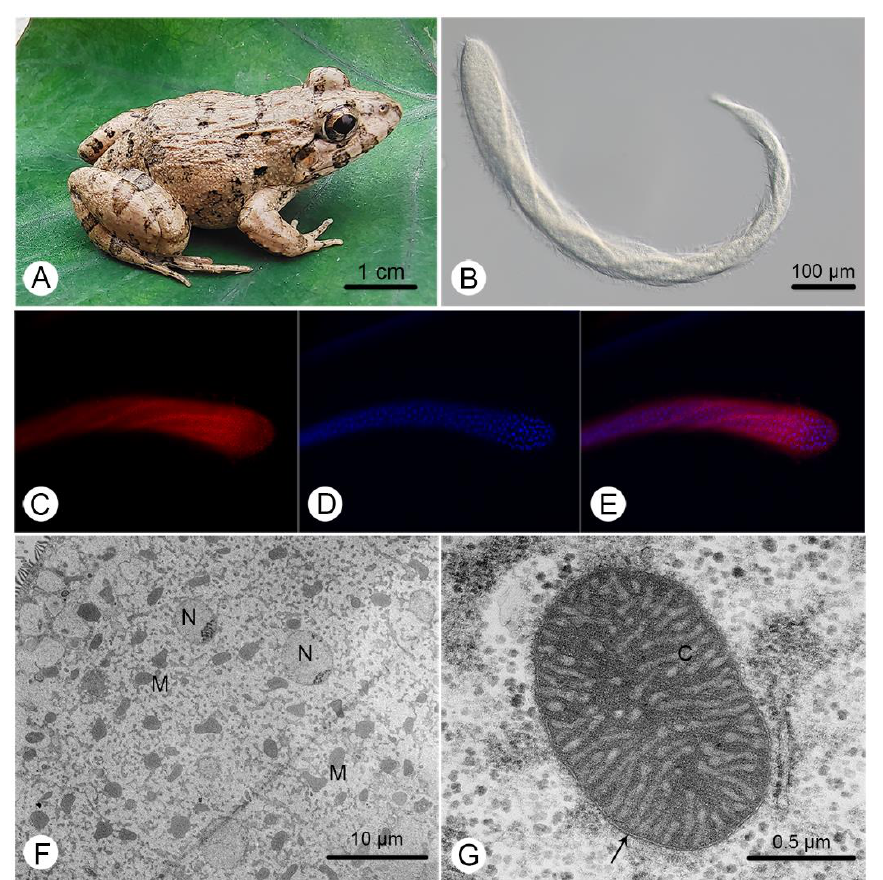
Figure 1. General characteristics of Cepedea longa , its host and its mitochondrion-related organelles. ( A ) The photo of the most common host of C. longa , Fejervarya limnocharis ; ( B ) a microscopic image of C. longa ; ( C ) a C. longa specimen stained with Mitotracker Red; ( D ) a specimen stained with DAPI; ( E ) a merger of ( C , D ); ( F ) a transmission electron microscope (TEM) image of C. longa , showing various MRO (M) shapes and ovoid nuclei (N); ( G ) a TEM image of the MRO of C. longa , showing the double-membrane (arrow) and cristae (C).